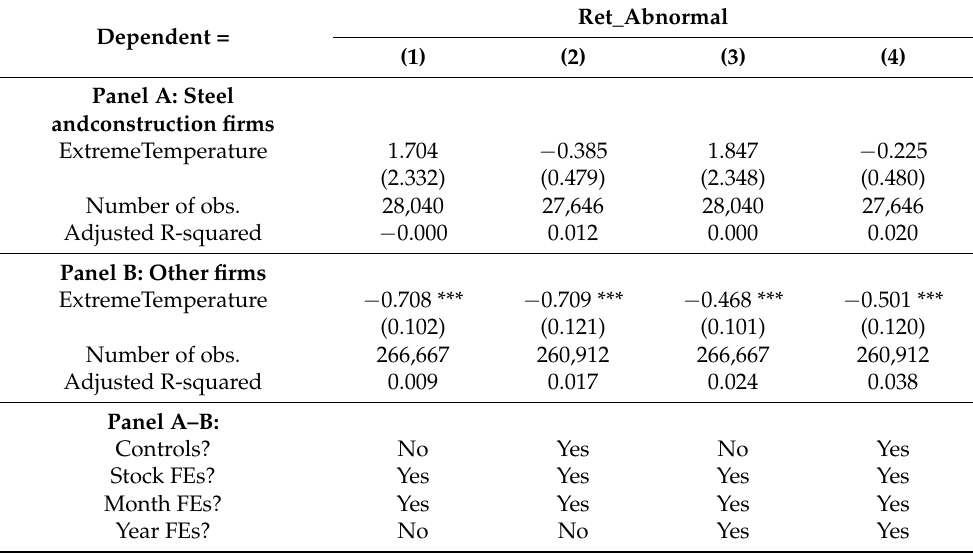
Table 9. The impact of extreme temperature: Steel and construction firms vs. other firms. Dependent